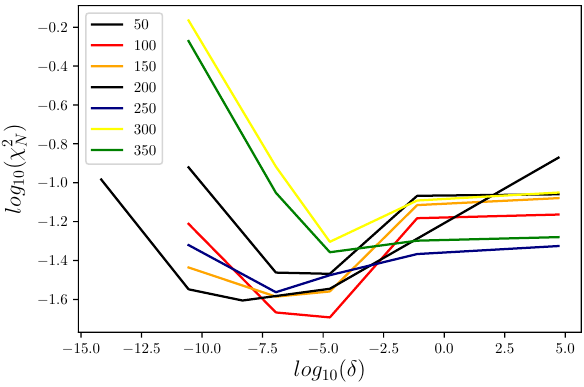
15 . 0 12 . 5 10 . 0 − − − ) versus log ( δ ) for T eff of a synthetic spectra Figure 3. log 10 ( χ 2 N having T eff =7600 K, log g =2.50 dex, v sin i =197 kms −1 , and with a S/N of 196. Each curve displays the minimization using different sets of nearest neigbor generated iteratively.